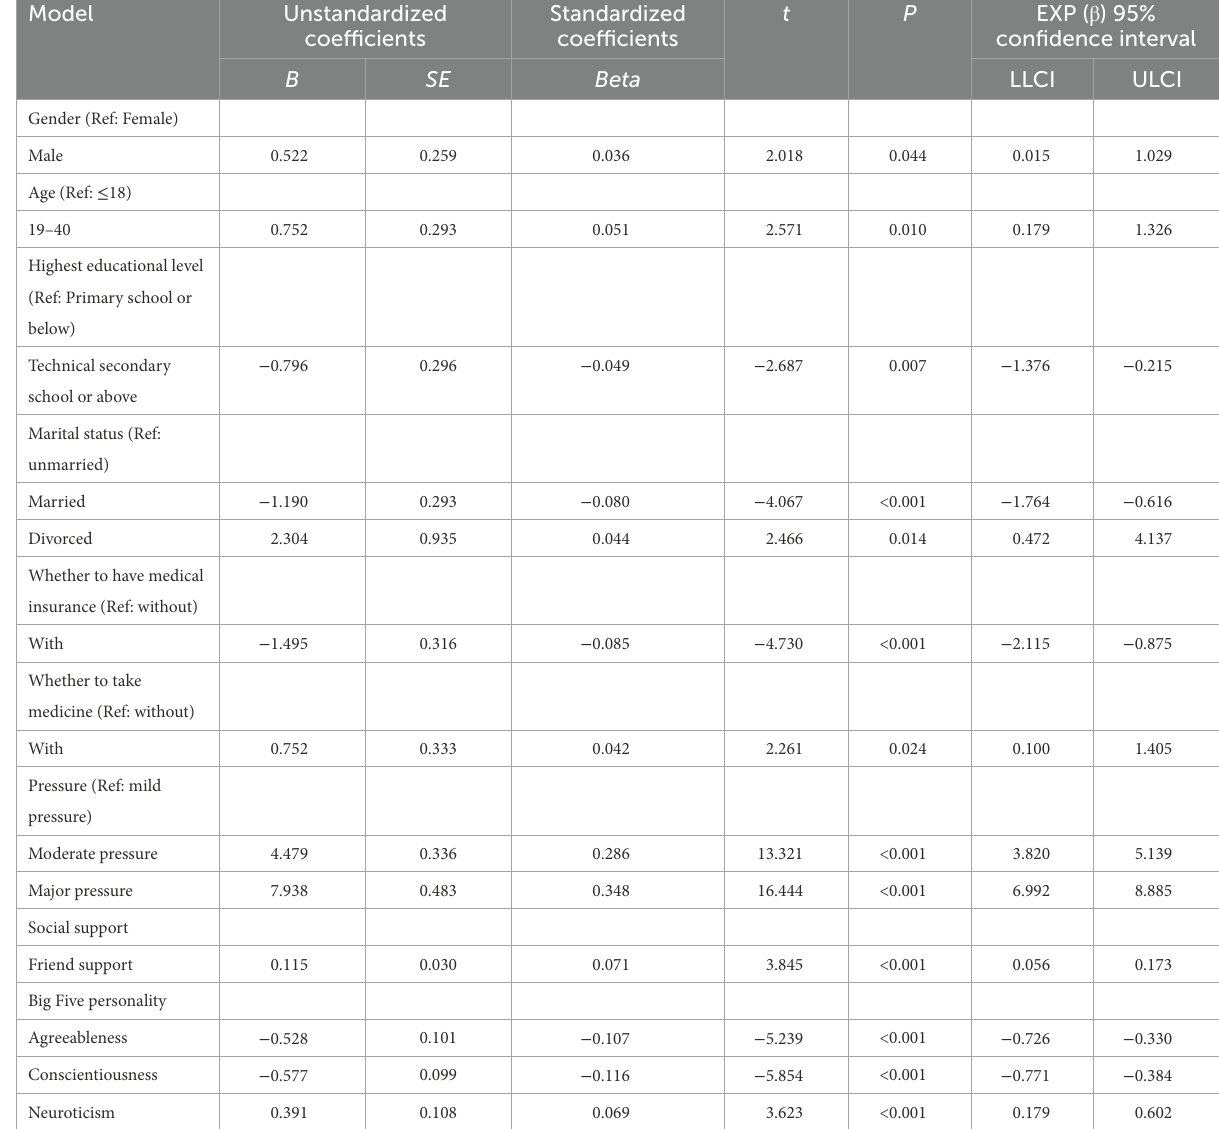
TABLE 7 Regression model analysis of depression in the media use